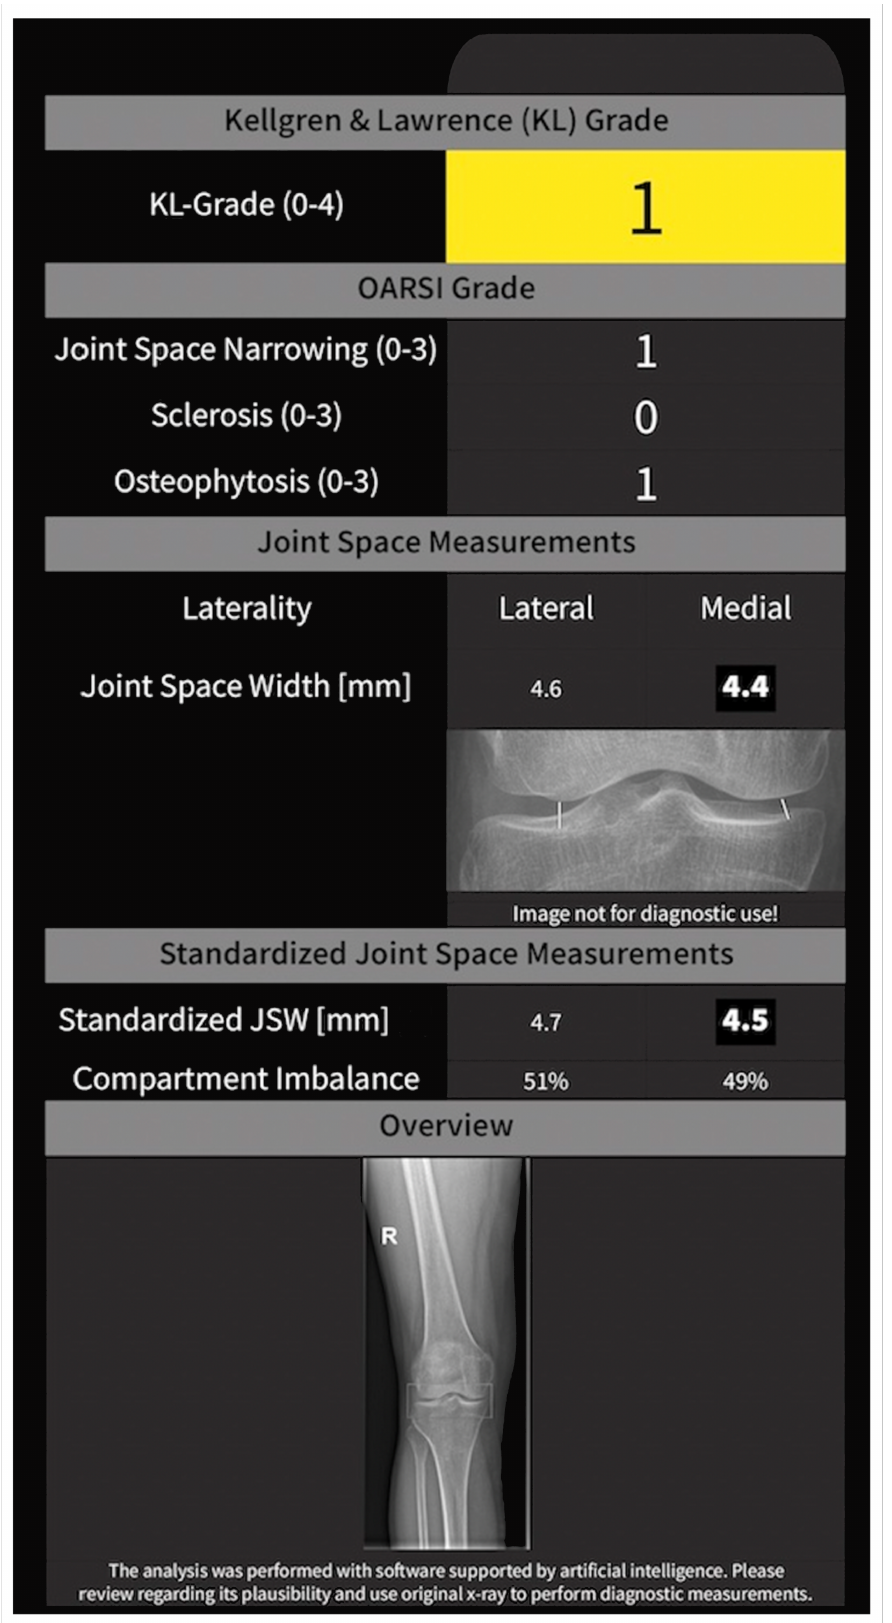
Figure 1. Exemplary AI-KOALA printed